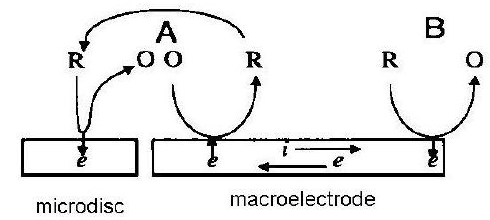
Figure 5. Mechanism of self induced redox cycling